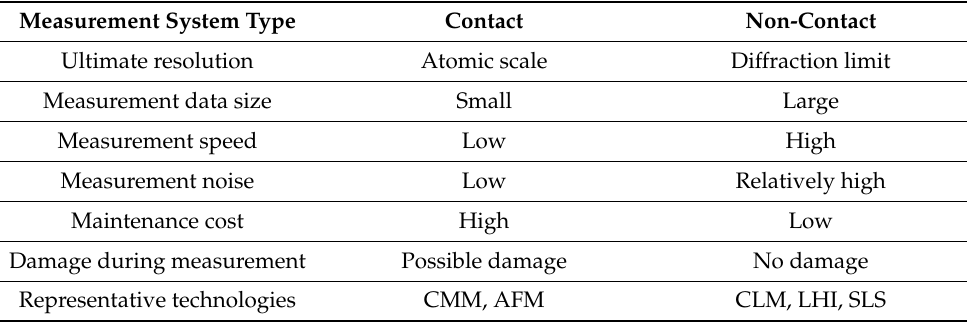
Table 1. The comparison of contact and non-contact 3D surface measurement